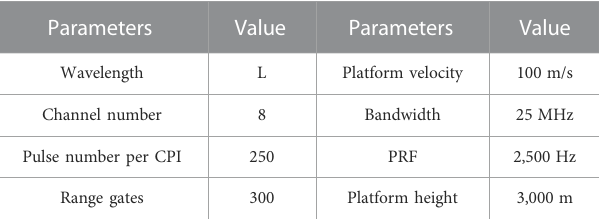
TABLE 1 Airborne radar system